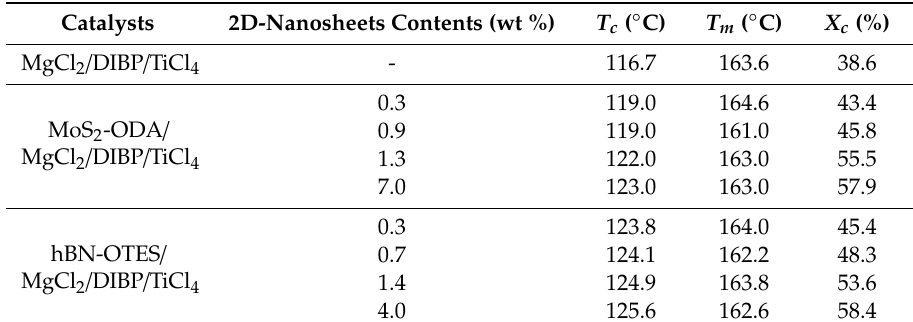
Table 2. Thermal properties of Polypropylene / 2-dimensional nanosheet (PP / 2D-nanosheet) composites with various nanosheet